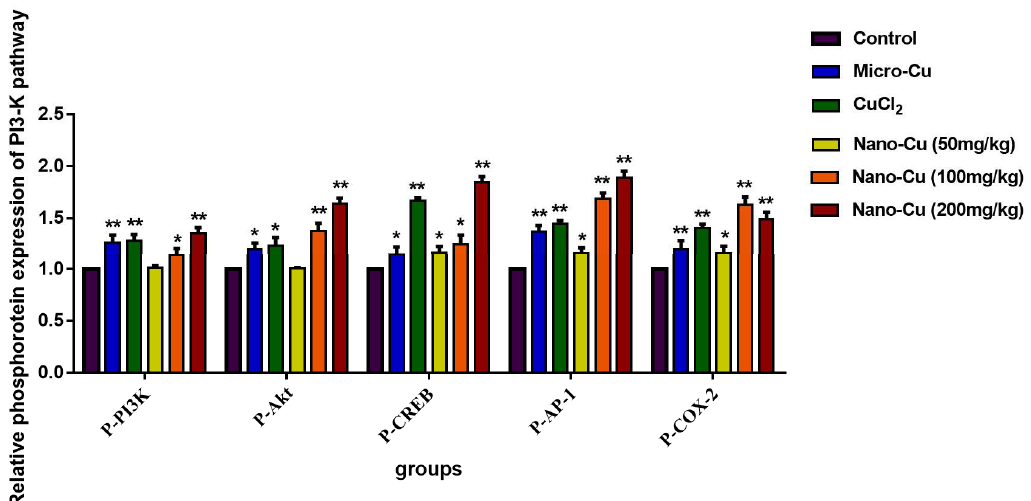
Figure 7. Expression levels of protein of the signaling pathway in rats given copper-containing preparations by oral administration for 28 consecutive days (test group/control). * p < 0.05 and ** p < 0.01 vs. control. Values represent means ± SD ( N = 10).